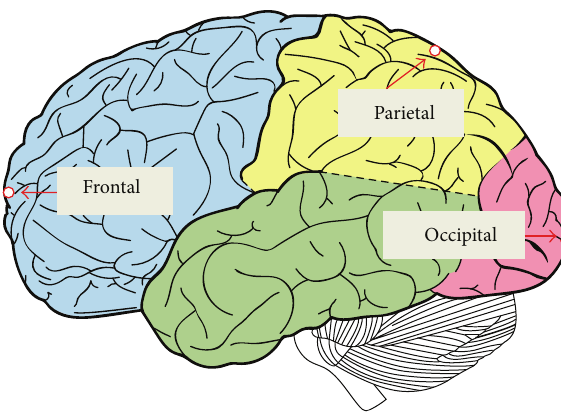
Figure 5: Impact force used in experiment and simulation.